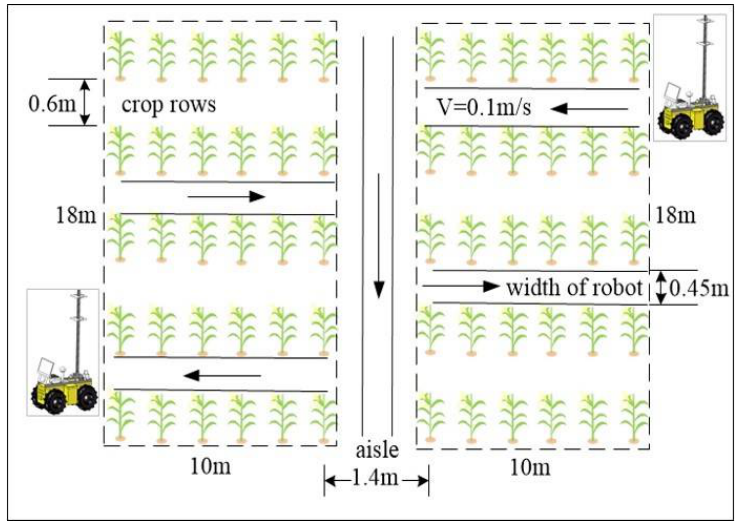
Figure 2. The experimental scheme.